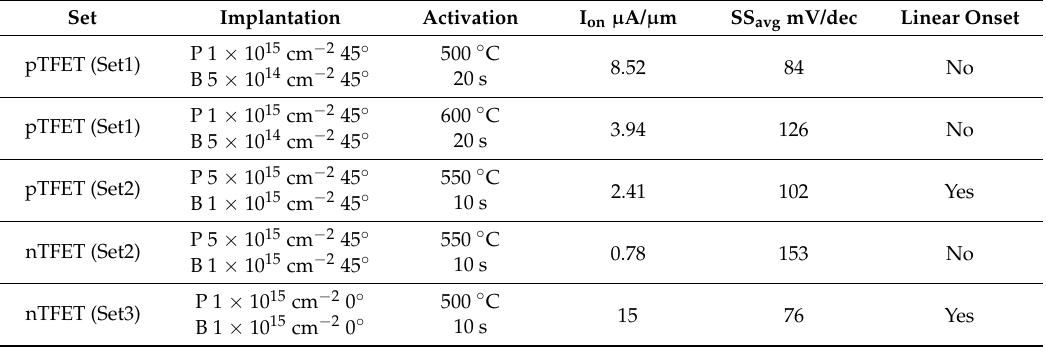
Table 1. A summary of different implantation and activation parameters and the corresponding results. I on was extracted at V ds = V on = V g − V off = − 0.5 V for I off = 1 nA/ µ m. SS avg is the average subthreshold swing from the minimum of drain current for 4 orders of magnitude at V ds = 0.1